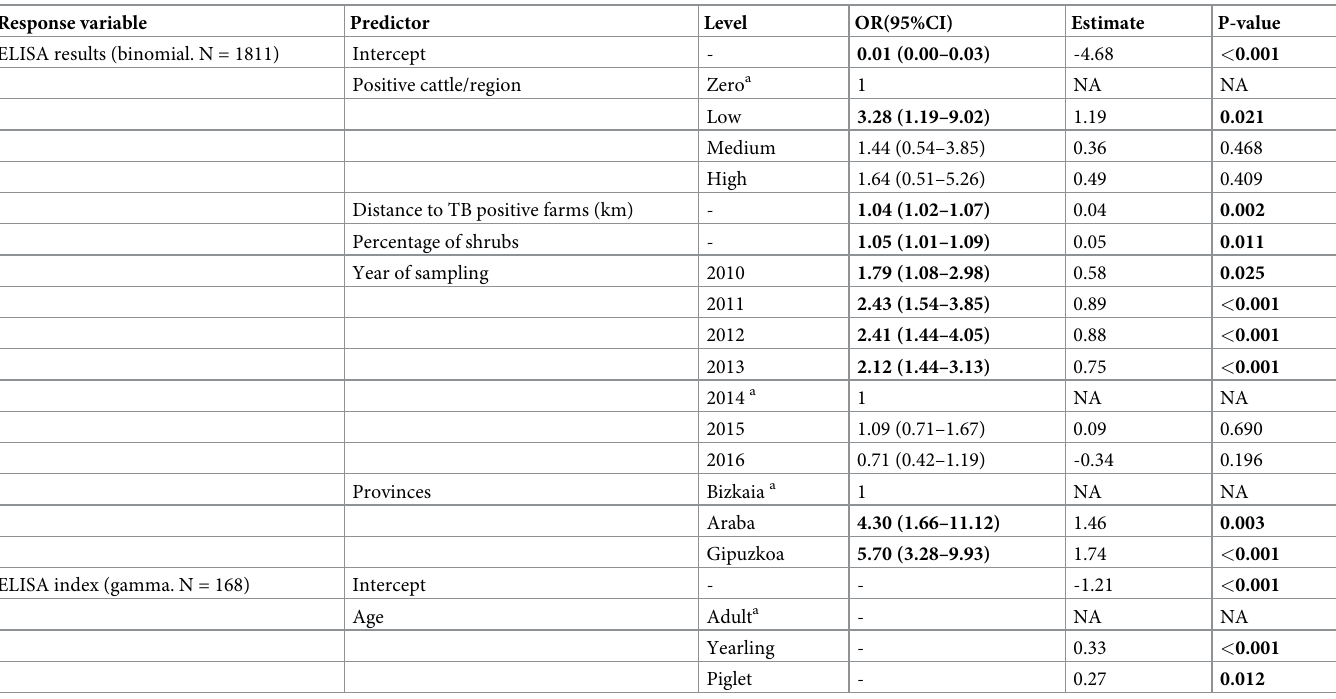
Table 4. Results of the generalized linear